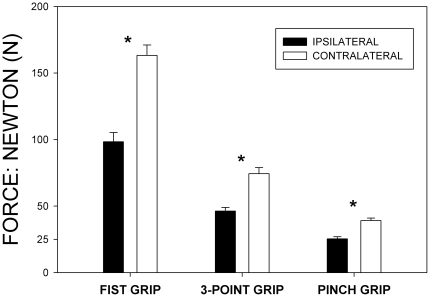
Hand force in chronic CRPS.Bars show a homogeneous reduction of hand force in Newton as compared to the contralateral side throughout the applied tasks. Significance: * p<0.001 ipsilateral vs. contralateral hand, paired t-test.